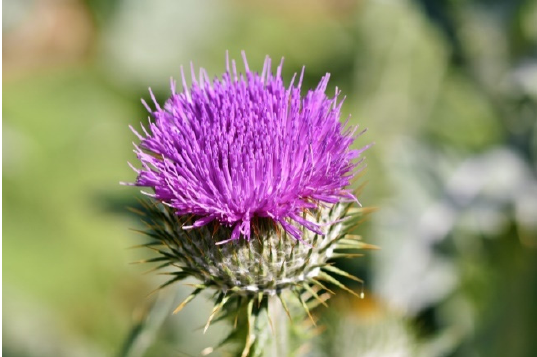
Figure 1. Cardoon plant ( Cynara Cardunculus L.). Photo by Capri23auto in Pixabay.